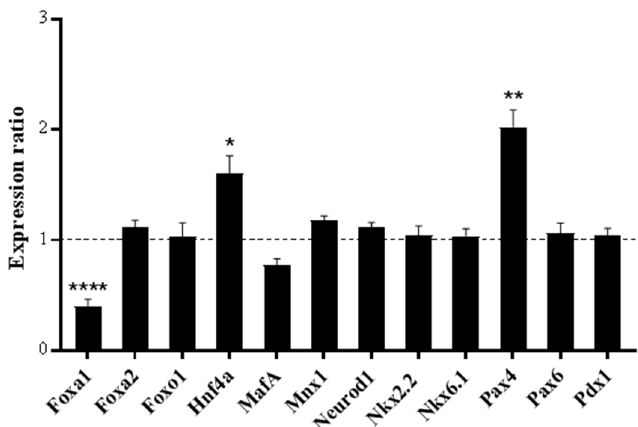
Figure 4. mRNA expression for transcription factors in ZnT8 haploinsufficient MIN6 cells. Expression of each gene was assayed through qPCR and is presented as a ratio compared to the expression level in sham-CRISPR MIN6 cells (control), as indicated by the dotted line. Experiments were carried out at 48 h. Data were analysed through t-tests and corrected for multiple comparisons. Error bars show ±SEM. n = 3. * p < 0.05 , ** p < 0.005, **** p < 0.0001.